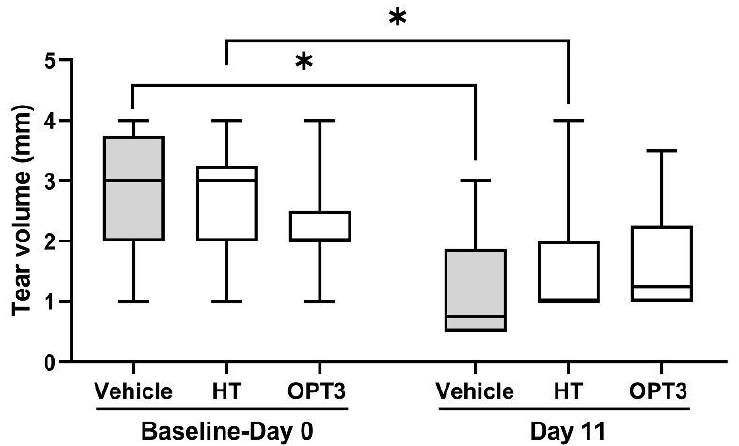
Figure 3. Effect of a selected crude OP extract (OPT3) (0.20 mg/mL) and HT (100 µ M/0.015 mg/mL), on tear volume of DS-exposed mice after topical application. * p -value < 0.05.